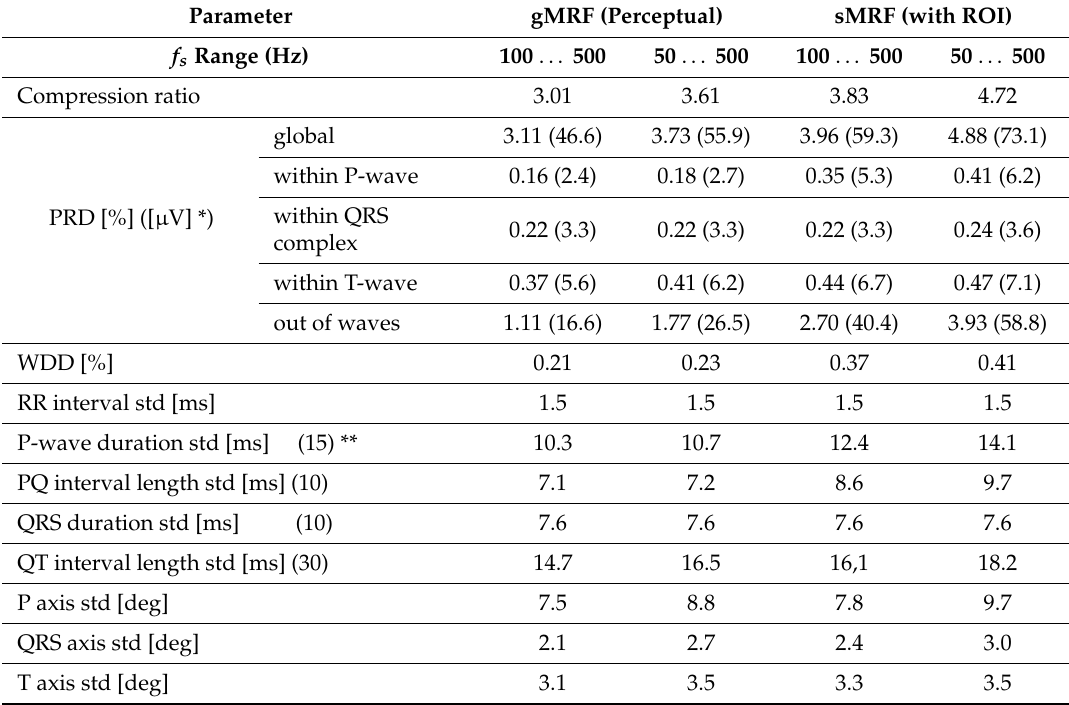
Table 1. Data compression, distortions and medical parameter differences for adaptive ECG sampling. Parameter gMRF (Perceptual) sMRF (with ROI) f s Range (Hz) 100 ...